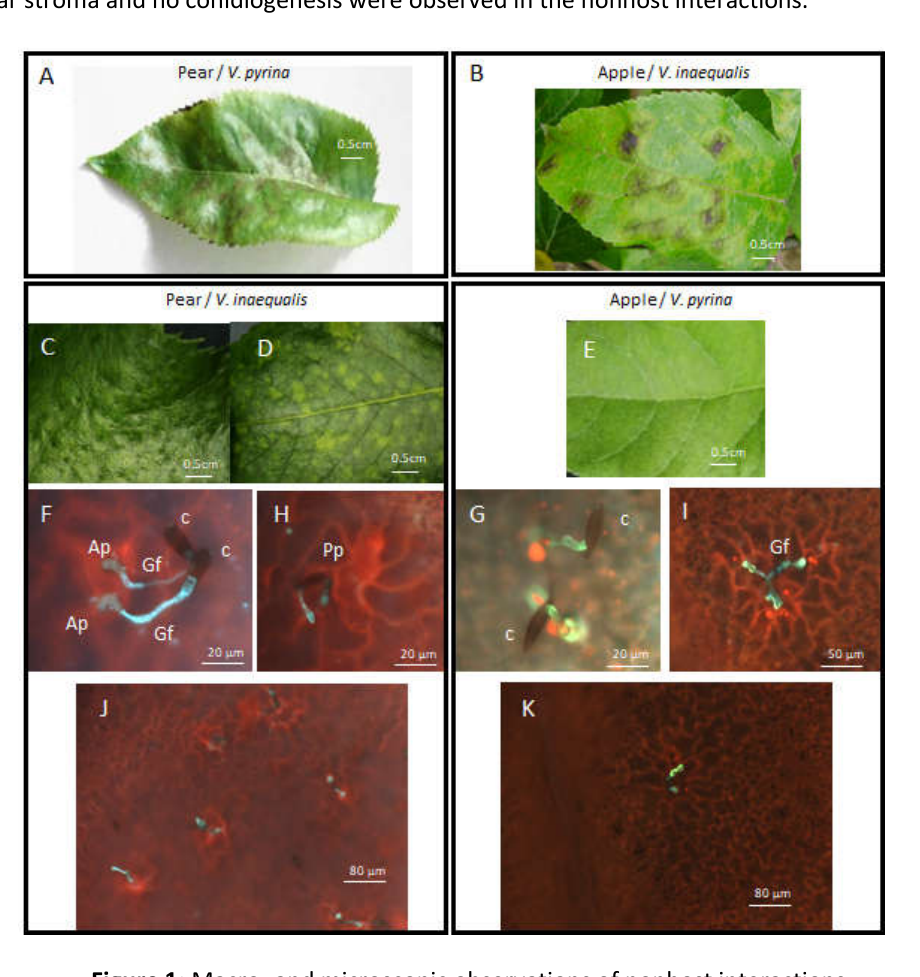
Figure 1: Macro- and microscopic observations of nonhost